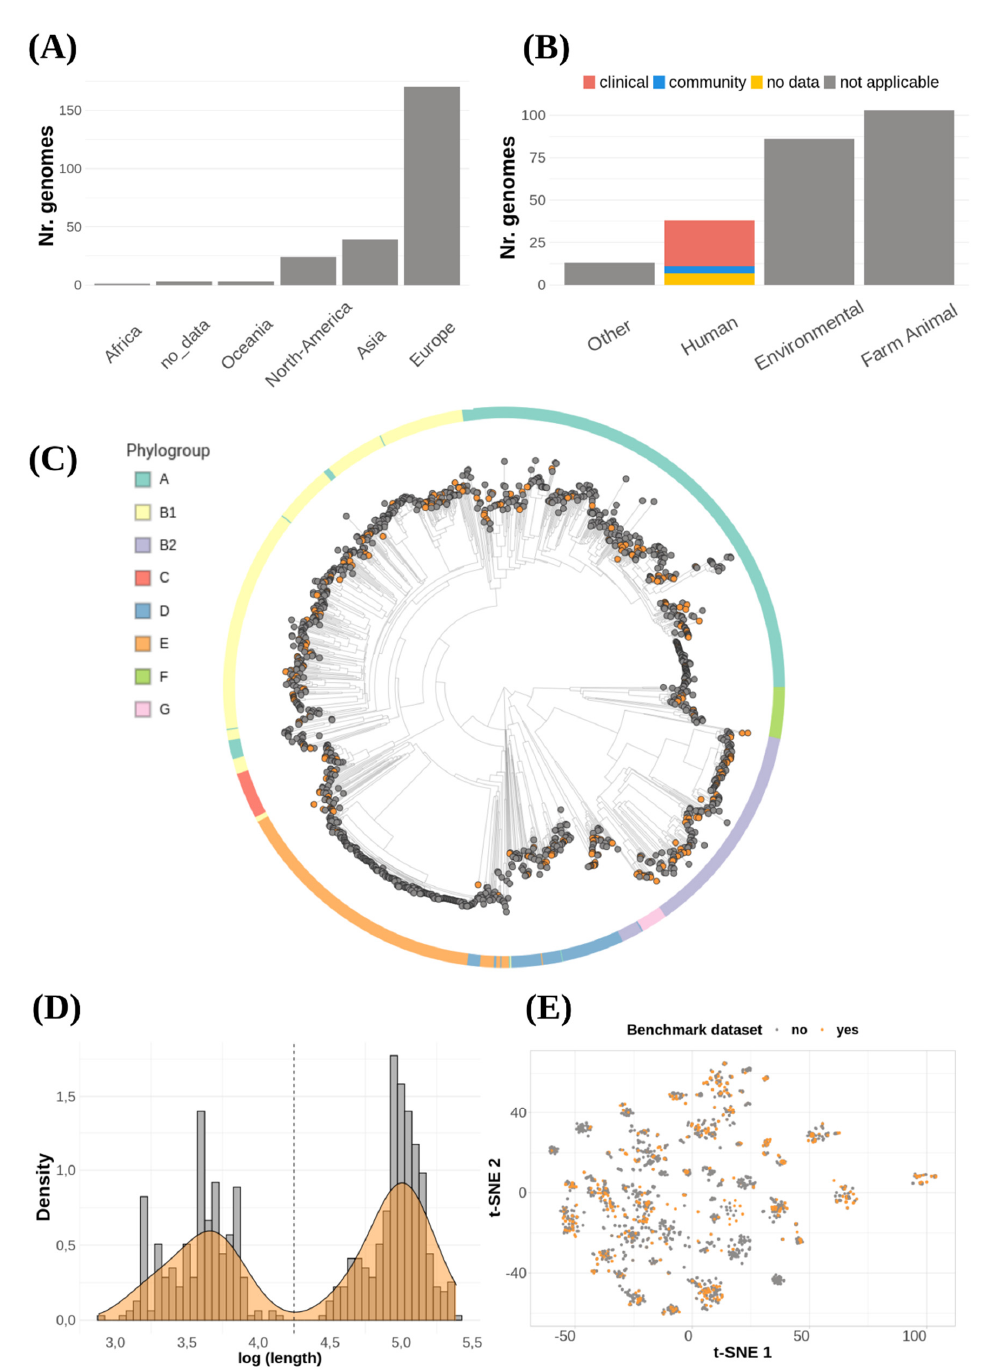
Figure 2. ( A ) Genomes distribution according to geographical location and ( B ) isolation source. ( C ) Core-genome clustering constructed using PopPUNK. We included 1381 complete E. coli genomes available at NCBI database. Orange tips ( n = 240) indicate genomes that were included in the benchmarking data set, and outer colors indicate phylogroups. ( D ) Plasmid length histogram and density plot. Dashed line indicates the cut-off length (18,000 bp) for considering a plasmid as small or large ( E ) tSNE plot based on plasmids k-mer distances obtained with MASH (k = 21, s = 1000). Plasmids included in this benchmark ( n = 631) are colored in